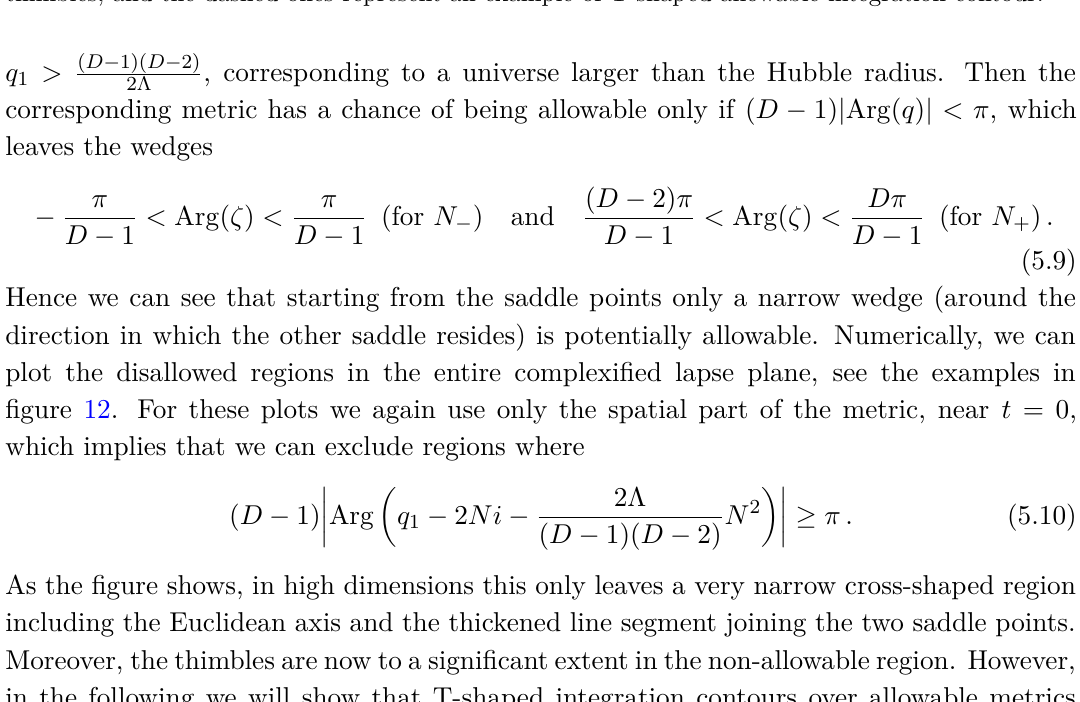
Figure 12 . The red regions show the domain in the complexified lapse plane that is non-allowable according to the spatial LSKSW bound only, in 7 dimensions (left panel) and in 100 dimensions (right panel). Here we have chosen Λ = ( D − 1)( D − 2) / 2 and q 1 = 10 . In higher dimensions, the non-allowable region grows, leaving only a narrow cross-shaped region available, but the saddles (blue dots) remain at the boundary of the allowable domain. The full black curves depict the thimbles, and the dashed ones represent an example of T-shaped allowable integration